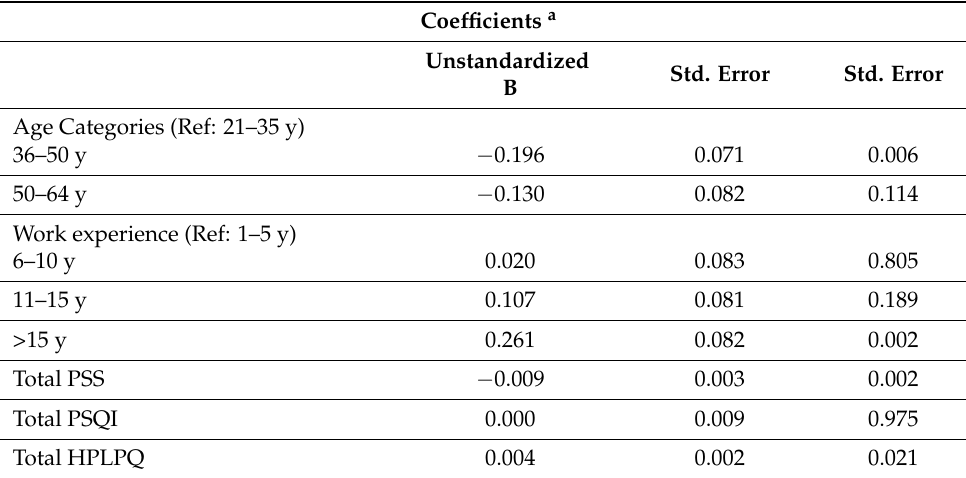
Table 5. Results from multivariate linear regression analyses that evaluated various participants’ characteristics as determinants of TSWQ.